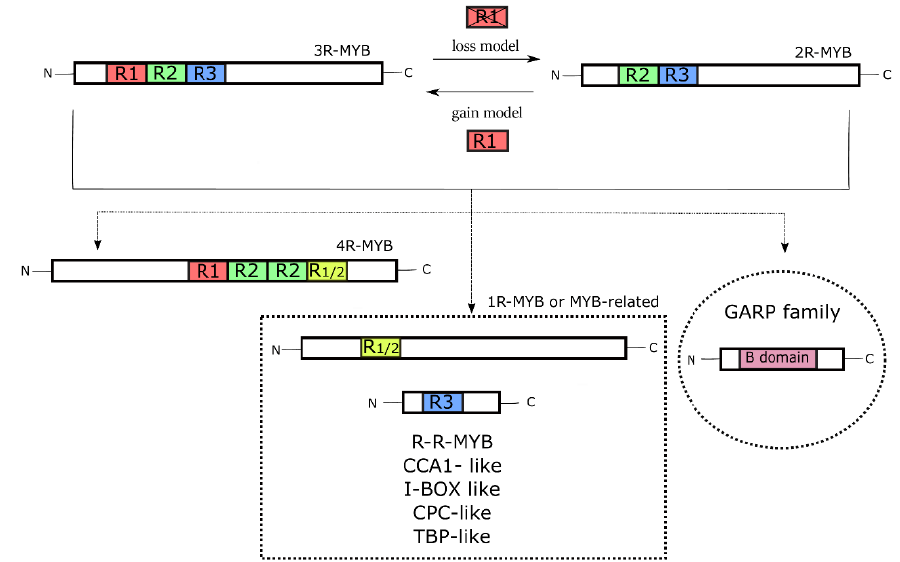
Figure 3. The evolution of the different types of MYB TFs. The alternative ‘gain’ or ‘loss’ model explains the origin of the 3R- and 2R-MYB types through the acquisition or deletion of the R1 repeat, respectively. The 4R-MYBs (with four R repeats) and the 1R-MYBs (or MYB-related ones) have evolved from these two types, with the last divided into five classes, all with a single R repeat. The GARP family of TFs is evolutionarily distant from the MYBs, even though its B-domain assumes a three-dimensional structure similar to that of the MYB domain.